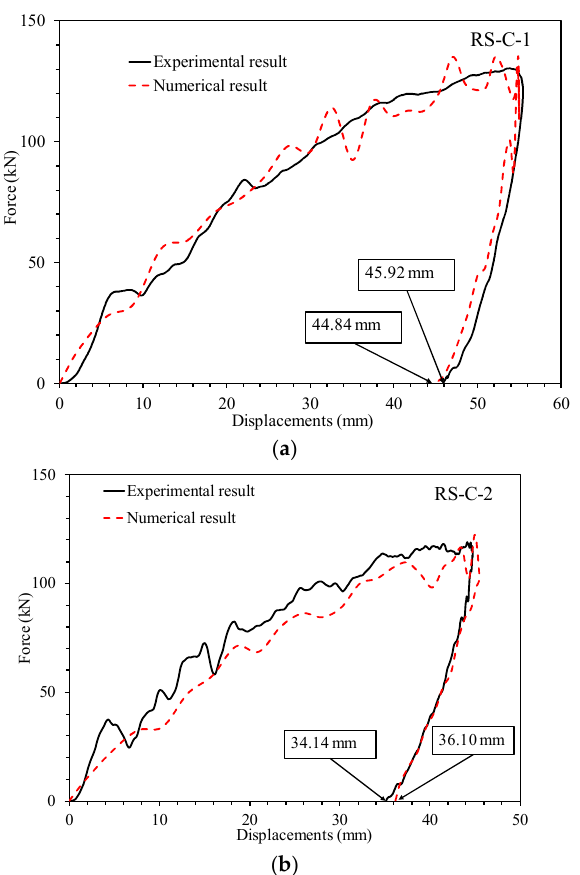
Figure 6. Predicted force-displacement curve of models compared with the test result: ( a ) model RS-C-1; ( b ) model RS-C-2.